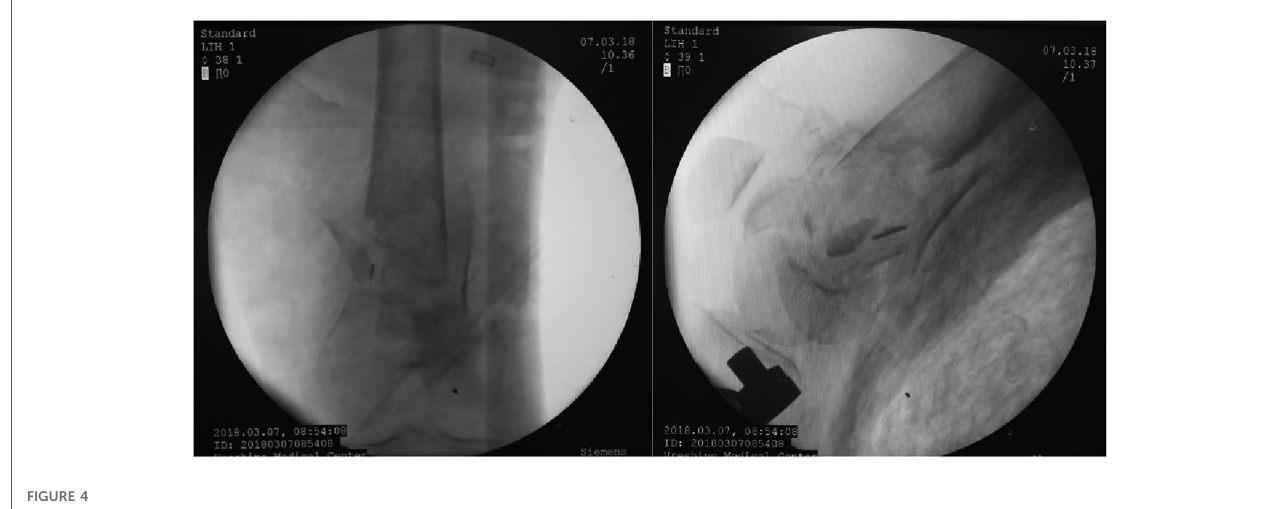
FIGURE 4 Good fracture position after reduction.